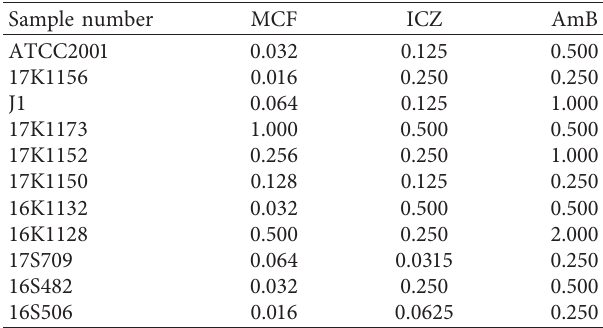
Table 2: MIC (mg/L) of experimental and standard strains. Sample